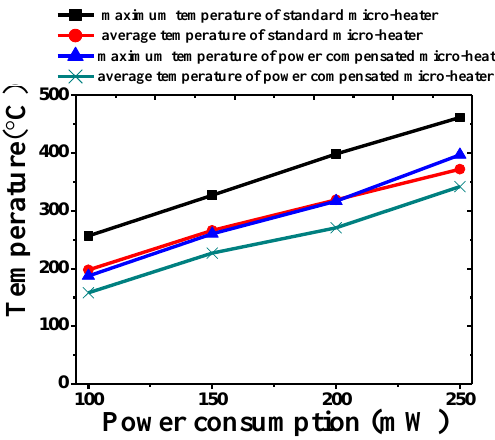
Figure 8. The measured maximum and average temperature at different power consumption of micro-heaters with standard micro-heater and power compensated micro-heater.